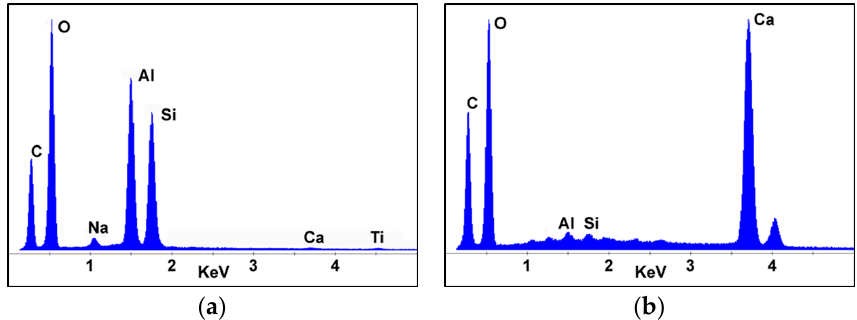
Figure 3. Typical energy dispersive X-ray spectroscopy (EDS) spectra of newspaper samples that facilitated SWCNT growth ( a ) and that did not facilitate SWCNT growth ( b ).